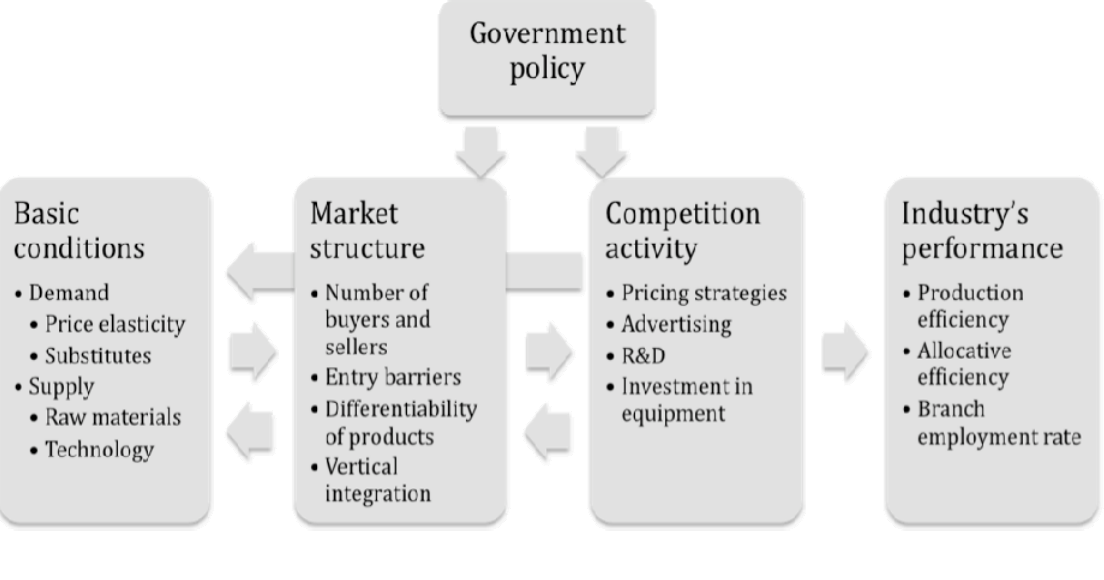
Figure 2. The SCP model (Adapted from source: Scherer and Ross,